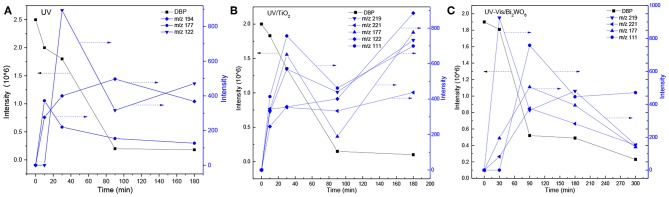
Time-dependent evolution profiles of DBP and its byproducts in different systems (A: UV; B: UV/TiO2; C: UV-Vis/Bi2WO6).